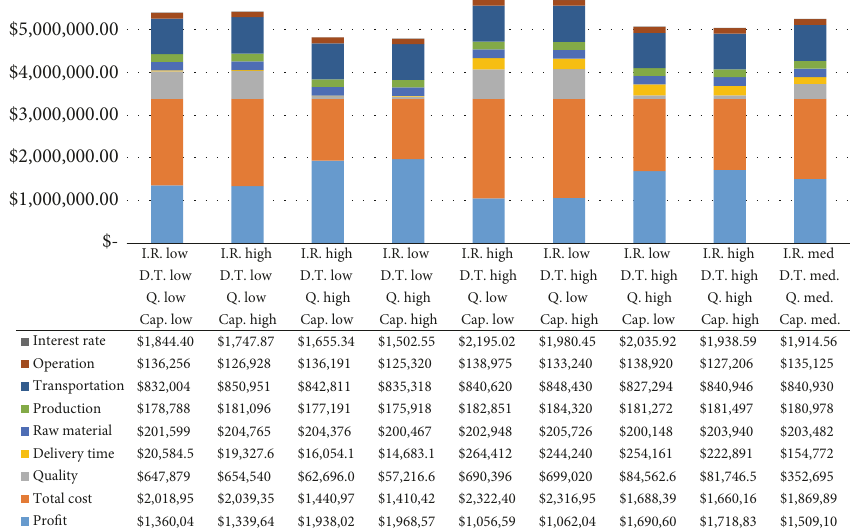
Figure 9: Profit, total costs, and